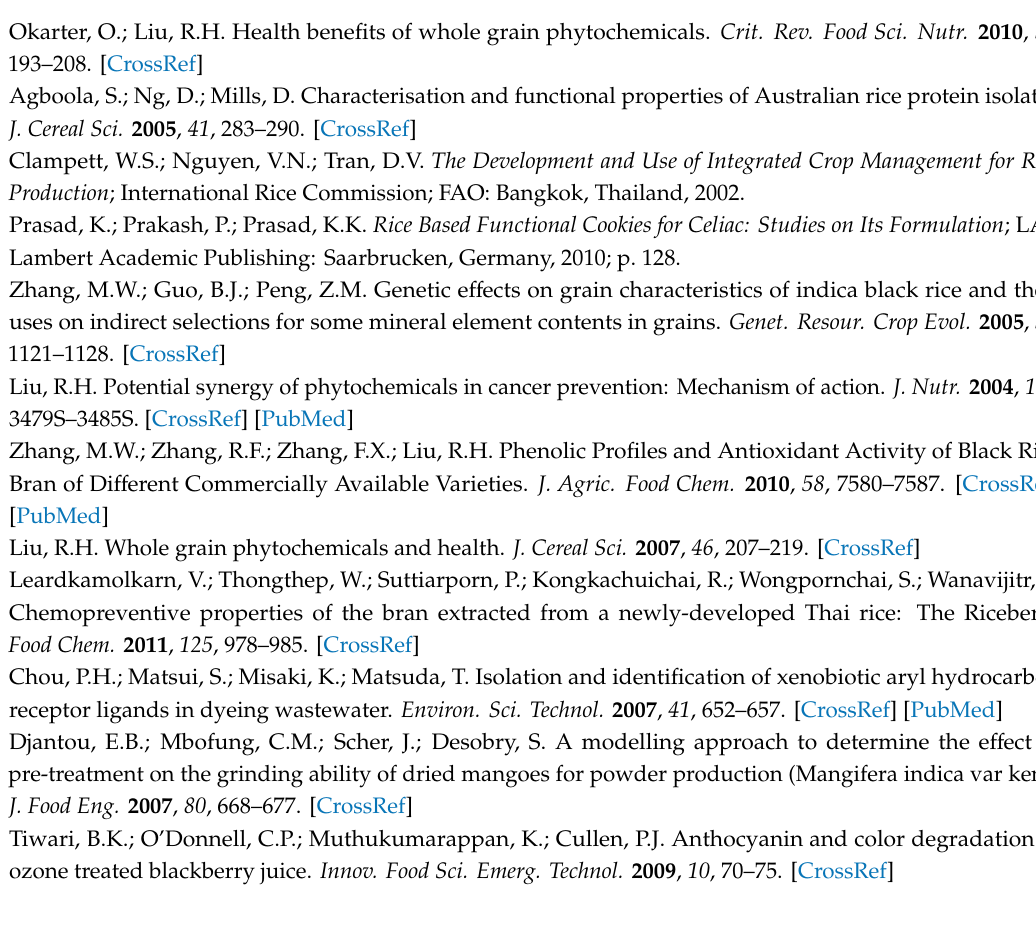
Figure S1: Isothermal degradation of TPC in black rice fractions F1 (a), F2 (b), F3 (c), F5 (d), F6 (e), F7 (f) extracts treated at di ff erent temperatures ( (cid:7) 60 ◦ C, (cid:4) 70 ◦ C, (cid:78) 80 ◦ C, 90 ◦ C, (cid:3) 100 ◦ C), Figure S2: Isothermal degradation of TAC in black rice fractions F1 (a), F2 (b), F3 (c), F5 (d), F6 (e), F7 (f) extracts treated at di ff erent (cid:51)